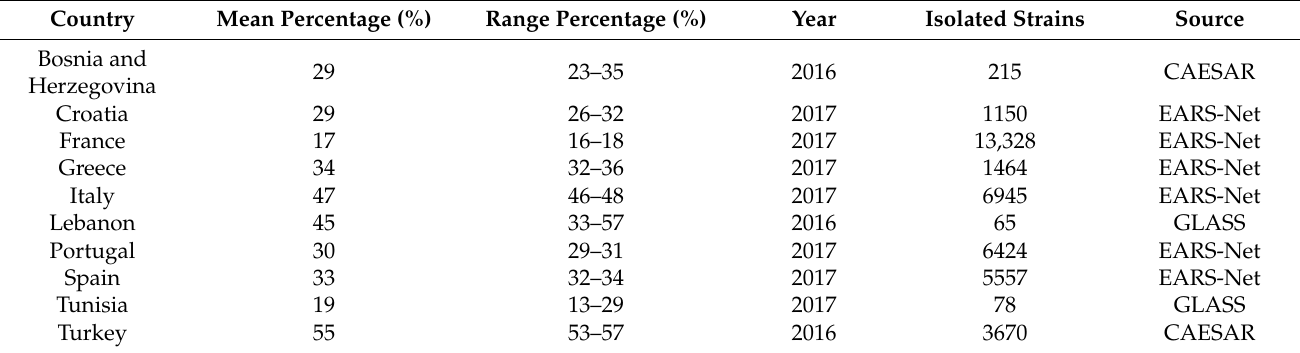
Table 2. Escherichia coli isolated strains resistant to fluoroquinolones in countries of the Mediterranean